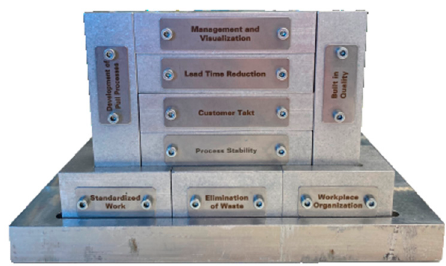
Figure 1. Initial assembly setup.